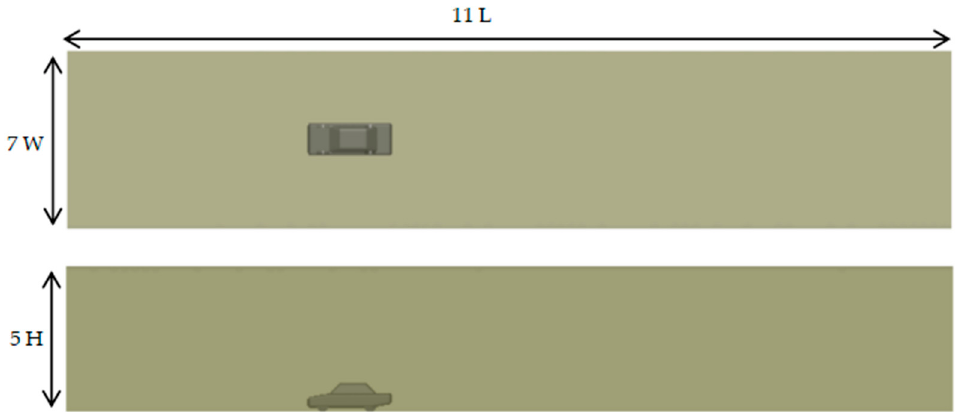
Figure 4. Computational domain.